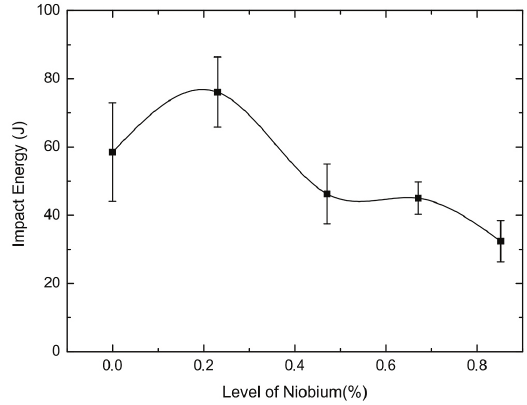
Figure 5. Changes in the Charpy energy of NCIs for various levels of Niobium additions.